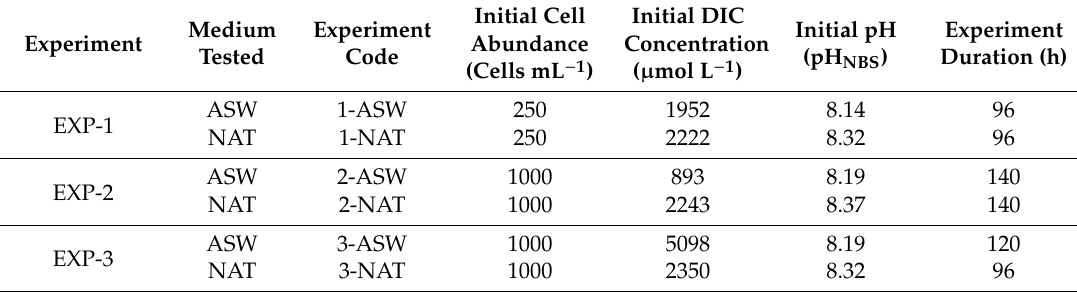
Table 1. Description of the experiments. Initial cell abundance (cells mL − 1 ) and dissolved